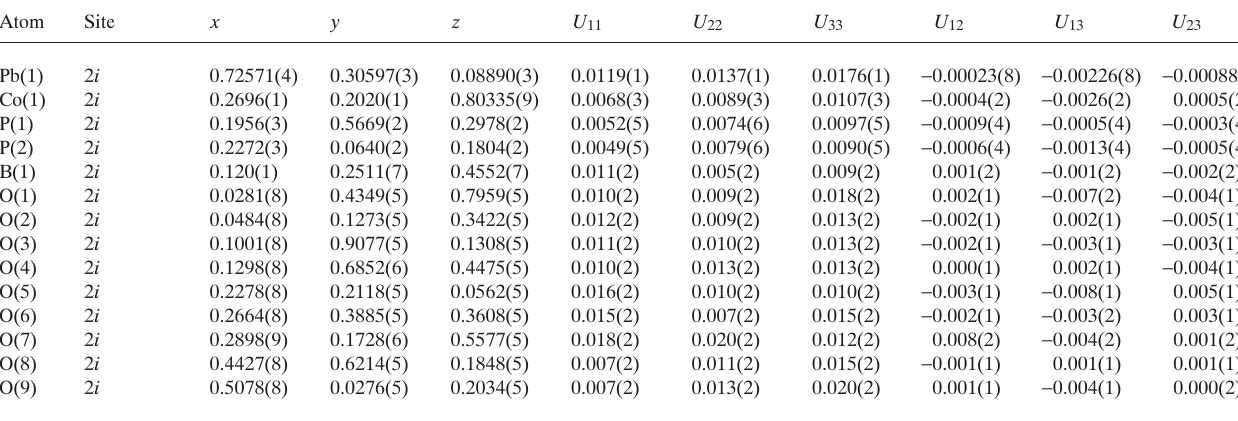
Table 3. Atomic coordinates and displacement parameters (in Å 2 ) .